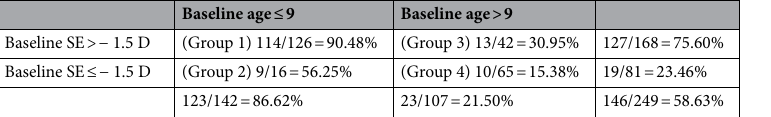
Table 3. Responder rates of 0.01% atropine treatment in subgroups. D diopter, SE spherical equivalent.